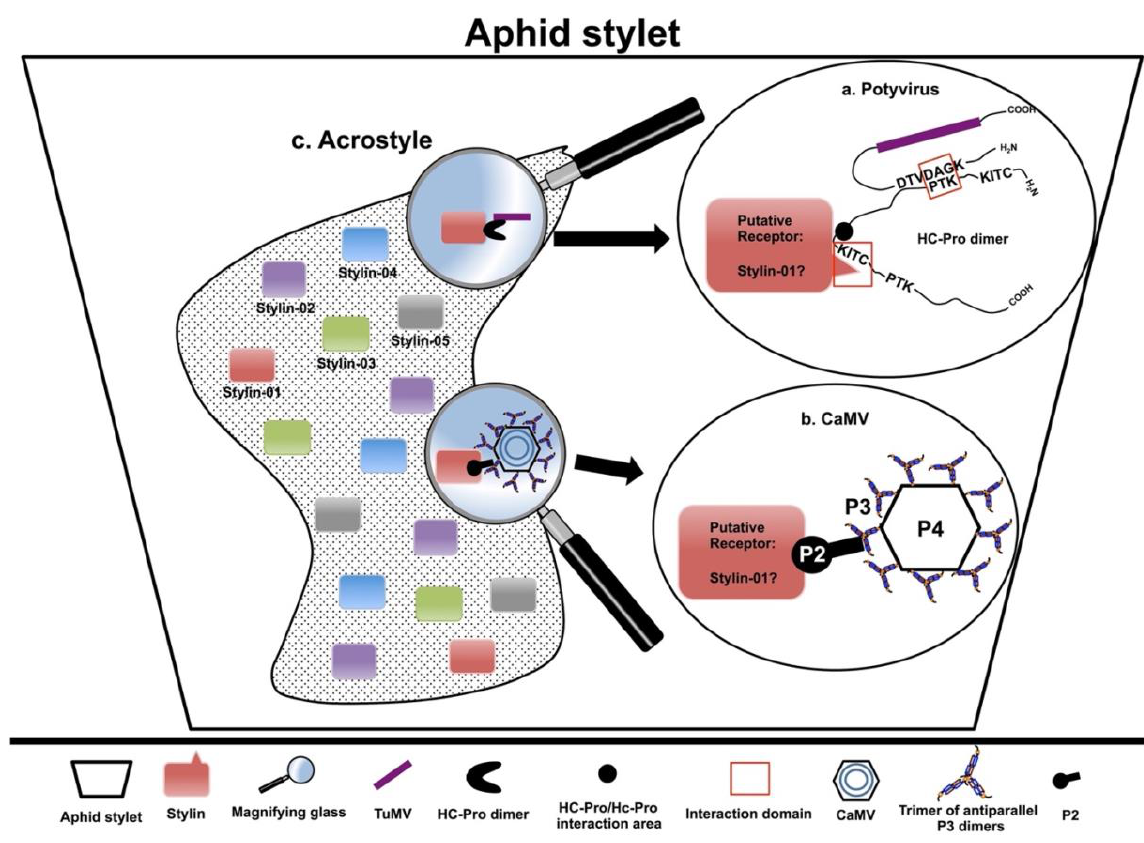
Figure 1 - Schematization of the HC mode of action for noncirculative viruses transmitted by aphids. (a) Potyvirus: shows Hc-Pro attached to putative receptors. (b) CaMV: shows the HC (P2) bound to putative receptor; P4 is the coat protein; P3 forms a network around the virus particle. At the distal tip of the aphid stylets, the acrostyle (c) harbors cuticular proteins named Stylins (Stylin-01 to -05). All known or suspected stylet-HC-virus particle interactions and the involved protein domains (when identified) are detailed in the maginifications on the